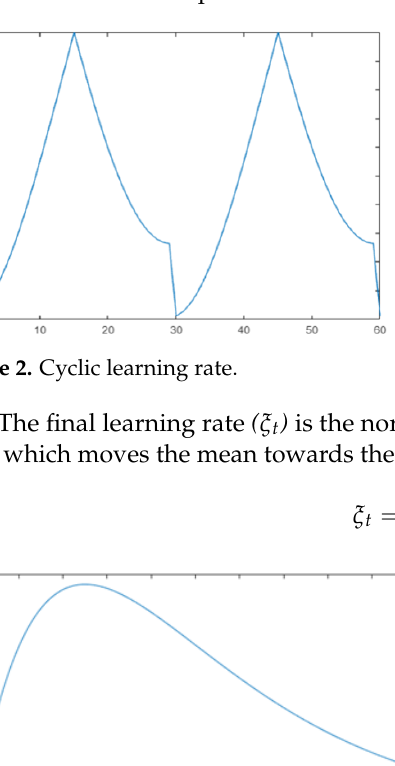
Figure 2. Cyclic learning rate.